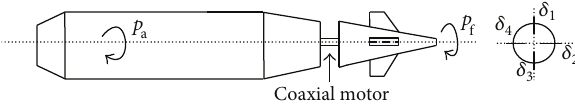
hand rule. Figure 2 is the schematic diagram of the coor- dinate system.